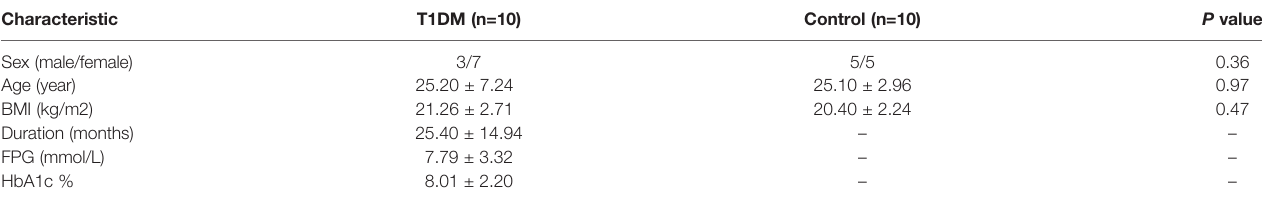
TABLE 1 | Characteristics of T1DM and control